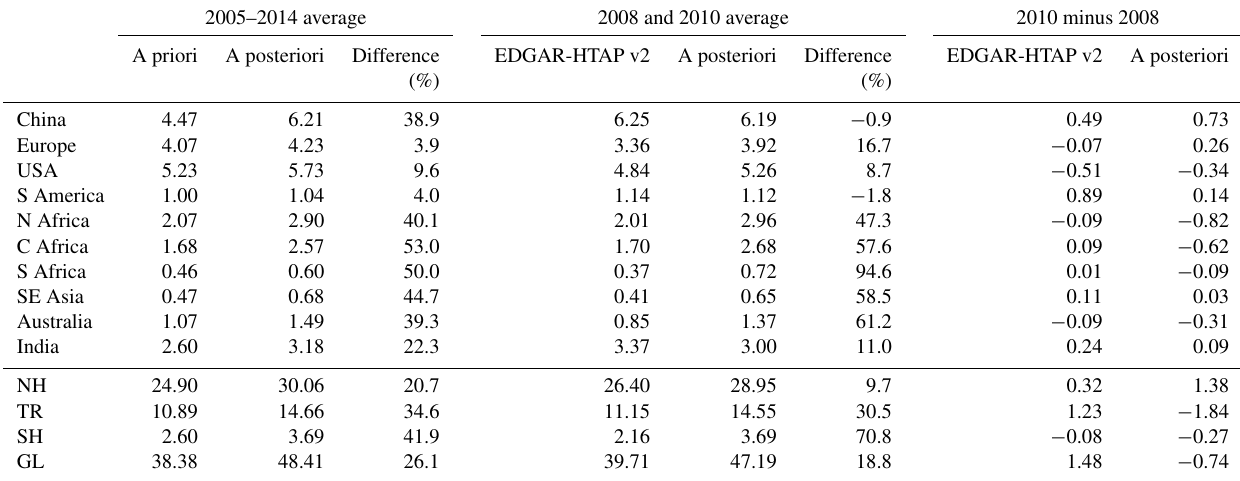
Table 3. The regional 10-year mean NO x emissions (in TgNyr − 1 ) obtained from the a priori emissions, a posteriori emissions, and the relative difference between these two emissions (in %) for the period 2005–2014 (left columns). The results are also shown for EDGAR- HTAP v2 emissions (as a reference) averaged over the years 2008 and 2010, the a posteriori emissions (the same results as in the left columns, but averaged over the years 2008 and 2010), and the relative difference between these two estimates (in %) (central columns), and for their difference from 2008 to 2010 (right columns). The results are also shown for the Northern Hemisphere (NH, 20–90 ◦ N), the tropics (TR, 20 ◦ S–20 ◦ N), the Southern Hemisphere (SH, 90–20 ◦ S), and the globe (GL, 90 ◦ S–90 ◦